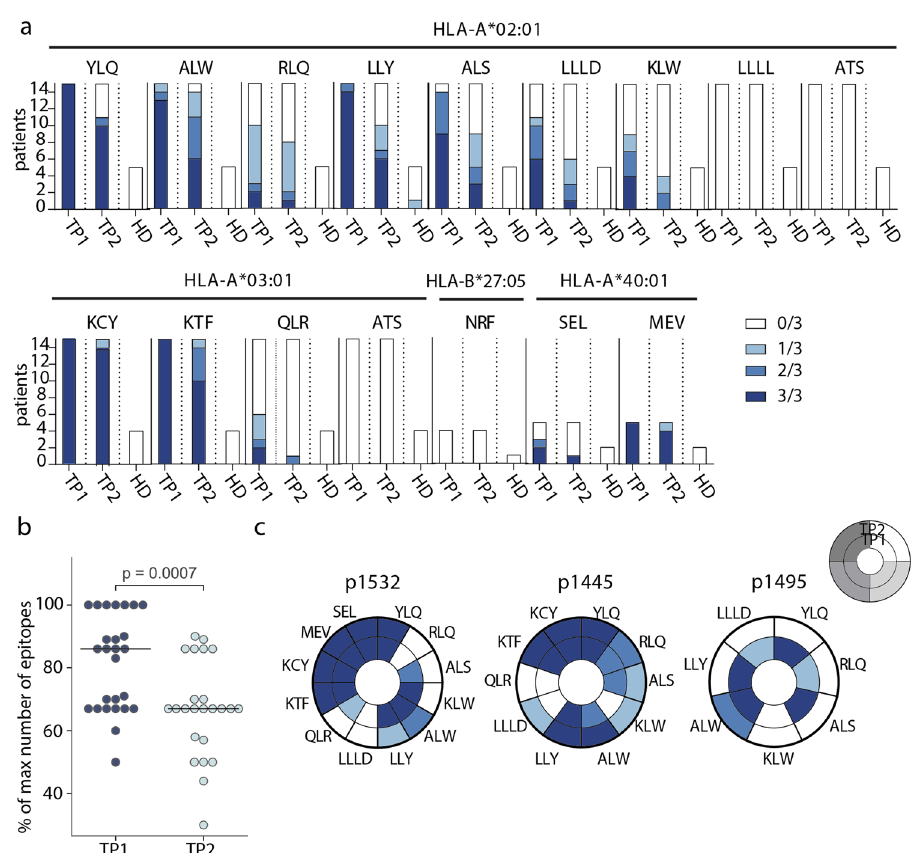
Fig. 2 Frequency of epitope-speci fi c T cells in CPs and healthy donors (HD). a Number of wells with detected epitope-speci fi c CD8 + cells after rapid in vitro expansion of PBMCs from CP ( n = 26) and HD ( n = 7). Bar height represents the number of HLA-allele carriers tested for response to each epitope. Color intensity indicates the number of wells containing MHC-tetramer + cells. Epitopes represented by three or four-letter codes and their restricting HLA alleles are listed at top; b proportion of recognized epitopes out of the total number of tested epitopes — i.e., epitopes presented by the individual ’ s HLA alleles. Each dot represents one donor, response in at least one well is considered positive. Paired Mann – Whitney test, with p-value indicated above; c changes in the detection of antigen-speci fi c cells after rapid in vitro expansion in TP1 (inner circle) versus TP2 (outer circle) for three representative donors (p1532, p1445, p1495). Each segment corresponds to epitopes indicated by three or four-letter